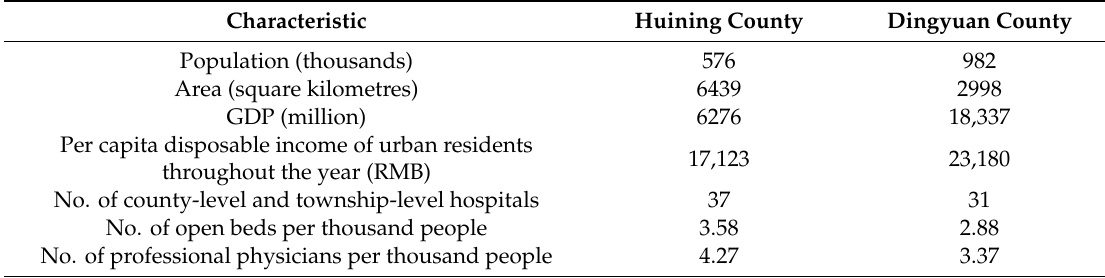
Table 1. Economic and health development information in two